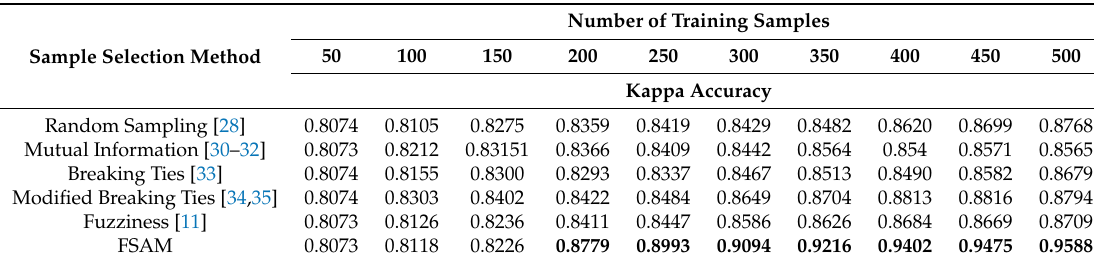
Table 8. Kappa ( κ ) accuracy obtained by LB Classifier with different number of training samples selected in each iteration from Botswana dataset with different sample selection methods from literature.